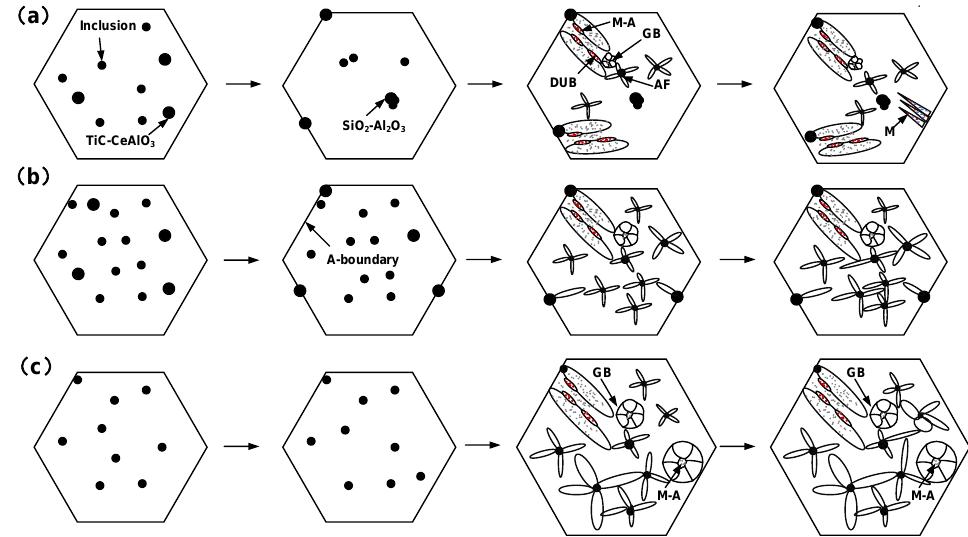
Figure 10. Schematic diagram of the relationship of inclusions, microstructure and mechanical properties under different heat inputs: ( a ) 1.45 kJ/mm; ( b )1.78 kJ/mm; ( c ) 2.31 kJ/mm.